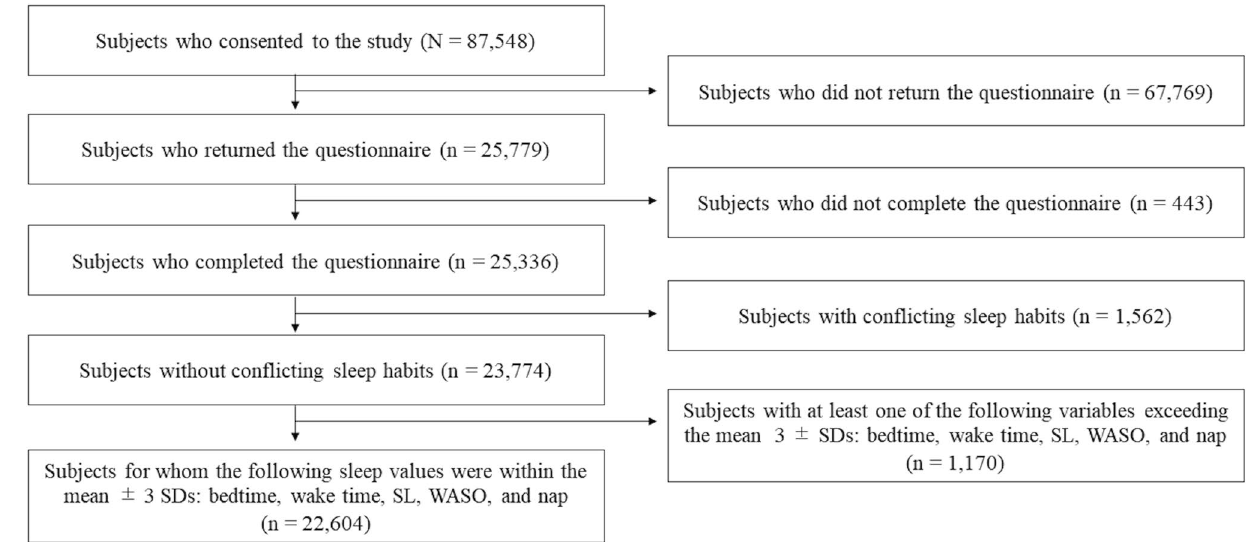
Figure 1. Selection of study subjects. Of the 87,548 subjects who were enrolled in the study, 25,779 responded to the questionnaire. Of the collected questionnaires, those of 443 subjects were excluded due to their responses having one or more deficiencies regarding indication of sex or age, or with the filling in of the questionnaire, 1,562 subjects were also excluded due to irrational sleep parameters (i.e., total sleep time is 0 h or less, time in bed plus nap is 24 h or more). Further, 1,170 subjects were excluded because sleep parameters habits (bedtime, wake time, sleep latency, wake after sleep onset, and nap) had outliers that exceeded the mean ± 3 standard deviations. Finally, the data of a total of 22,604 subjects were analyzed. Abbreviations: SD, standard deviation; SL, sleep latency; TST, total sleep time; WASO, wake after sleep